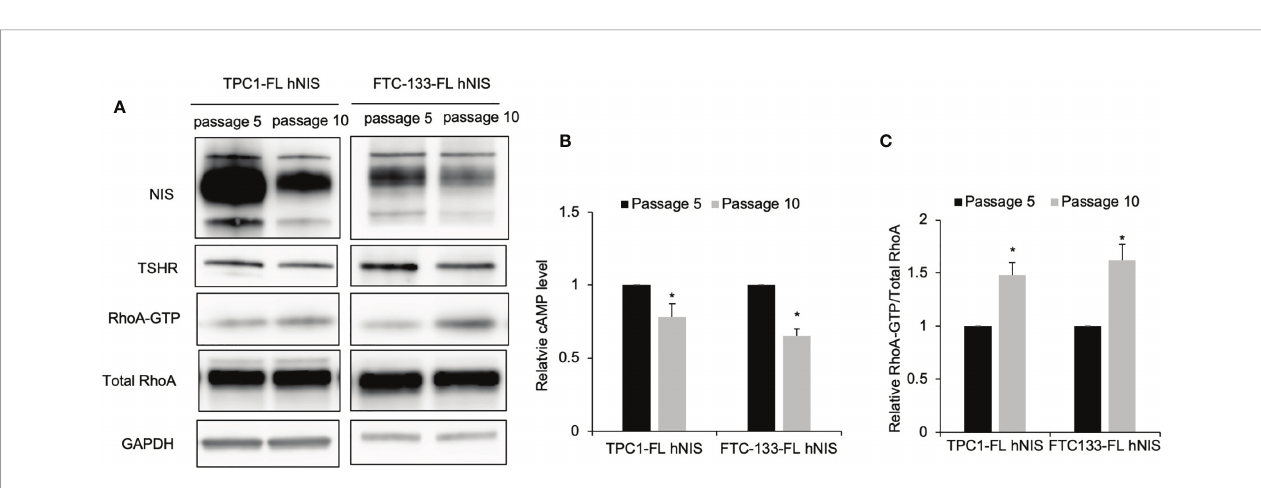
FIGURE 5 | G a s signaling is inhibited while G a 12/13 activation in thyroid cancer cells undergoing dedifferentiation. (A) Immunoblot of NIS, TSHR, RhoA and GAPDH from total cell lysates and RhoA after GST-Rhotekin pull-down (RhoA-GTP form) in FTC-133-FL hNIS and TPC1-FL hNIS cells at passage 5 or passage 10. GAPDH is used as a loading control for normalization. Data are representative of 3 sets of independent experiments. (B) Bar chart, cAMP levels in FTC-133-FL hNIS and TPC1-FL hNIS cells at passage 5 or passage 10. Data are representative of 3 sets of independent experiments. (C) Bar graphs, normalized ratios of active RhoA relative to total RhoA levels. Data represent means ± SEM of 3 independent experiments. * P <